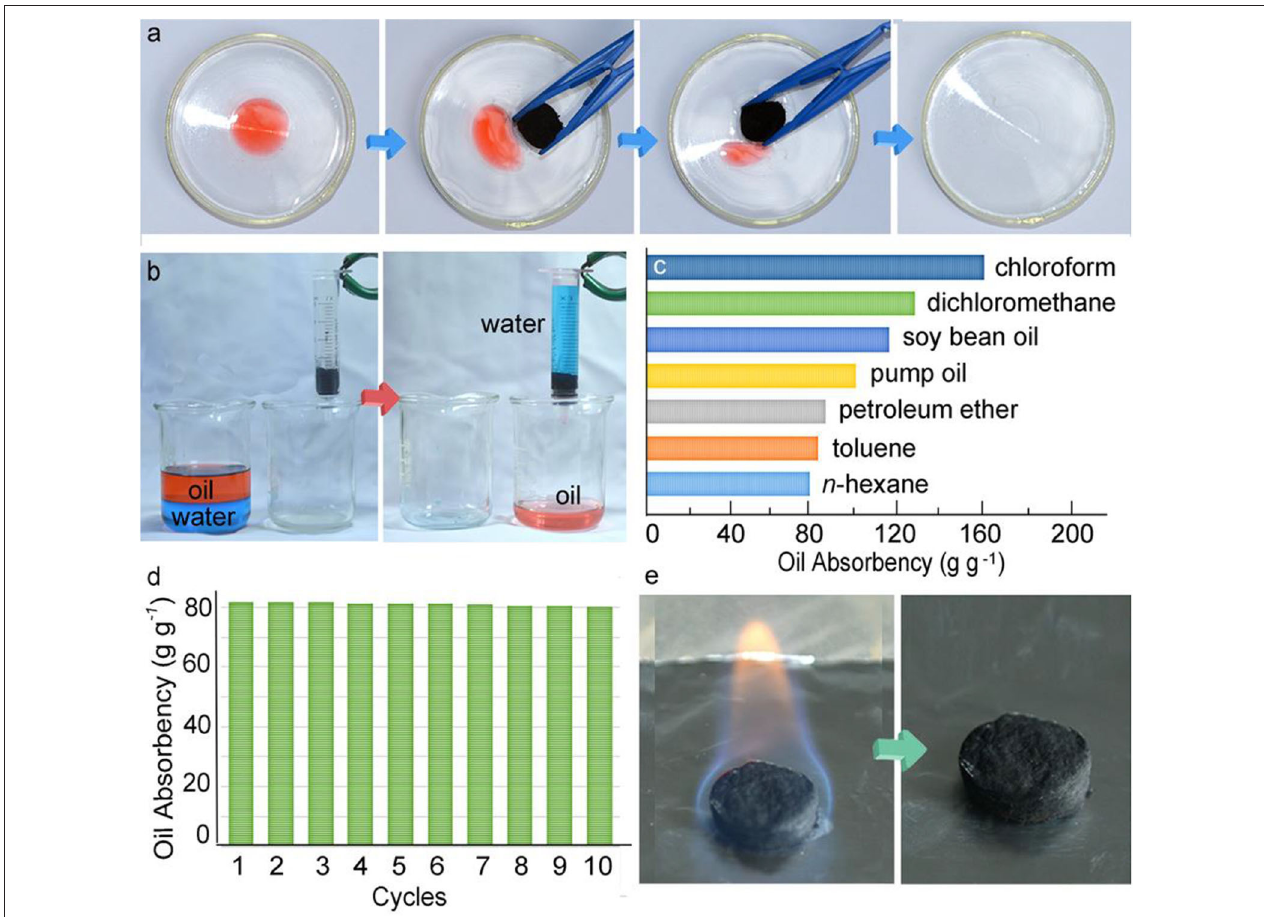
FIGURE 13 | Digital images showing the (a) absorption of oil (b) separation process, (c) absorption capacity, (d) cycles, (e) combustion of oil in pressure-sensitive and (PSC) gel. Adapted from Li et al. (2017a). With permission from the American Chemical Society, copyright 2017.